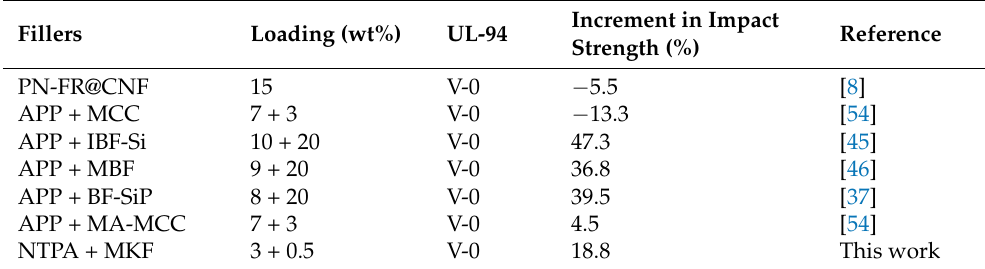
Table 4. The detailed comparison with previously reported flame-retardant and toughened PLA materials containing